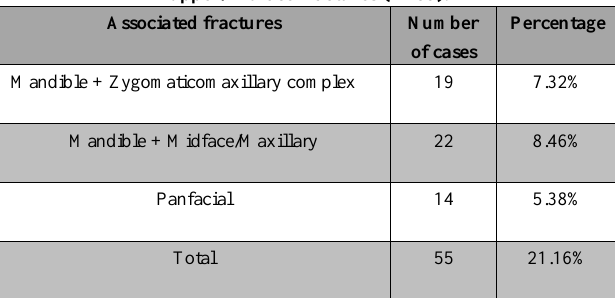
Table 5. Distribution of mandibular fracture associated with upper/midface fractures (n=